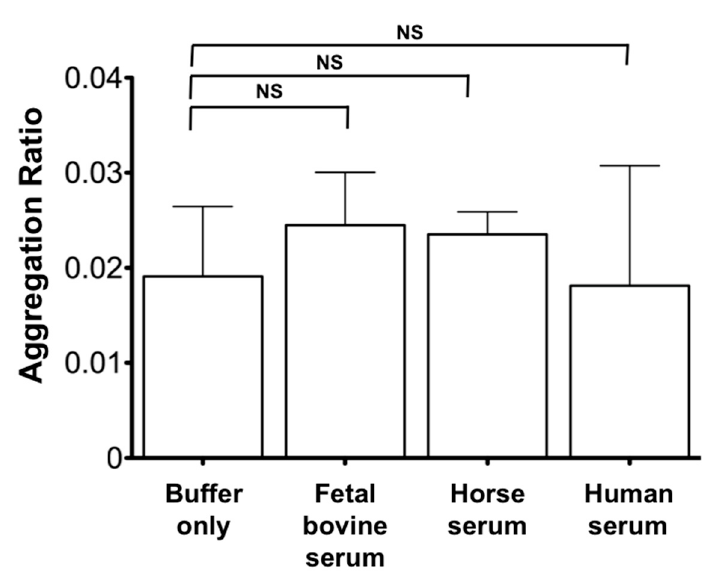
Figure 5. Utility of the AuNR-LSPR platform for cyto- c sensing in sera from different sources. Serum from fetal bovine, horse, and human were used to compare the utility of our AuNR-LSPR platform for cyto- c sensing. Cyto- c at a standard concentration of 0.1 ng/mL was sparked into these sera to evaluate the sensitivity of cyto- c sensing compared with that without serum. Results are mean ± SEM (n = 3), NS p > 0.05, * p < 0.05, ** p < 0.01, *** p < 0.001.